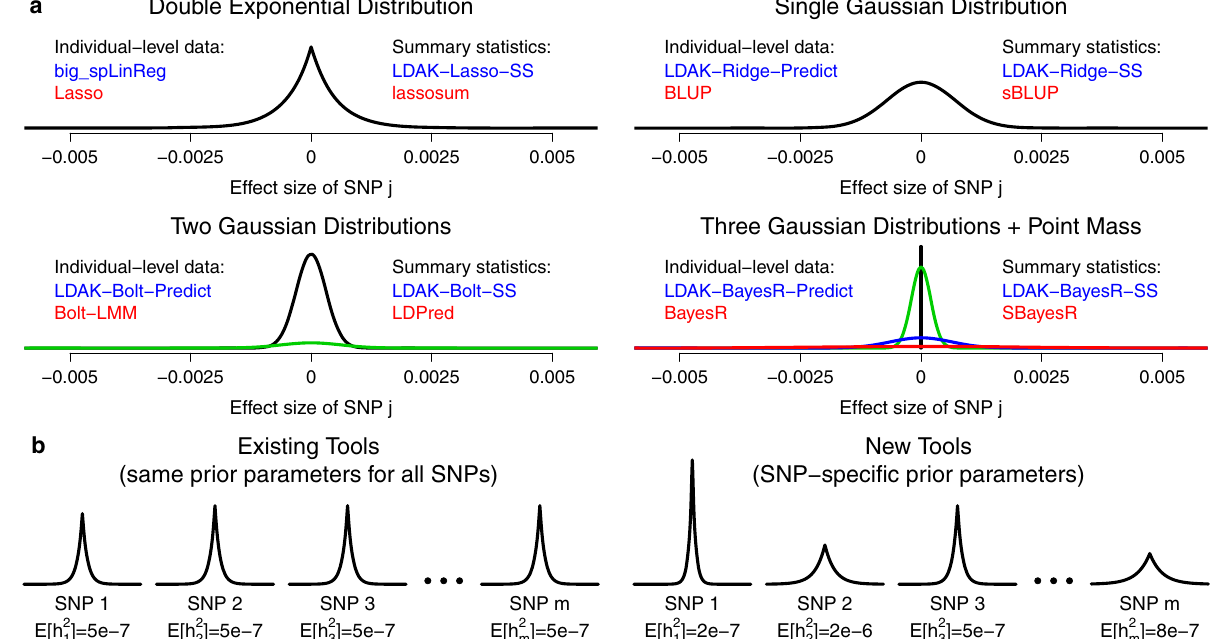
Fig. 1 Prior distributions for SNP effect sizes. a We divide prediction tools based on the form of the prior distribution they assign to SNP effect sizes, and whether they use individual-level data or summary statistics. For each of our eight new tools (names in blue), there is an existing tool that uses the same prior distribution form (names in red). b Having selected the form of the effect size prior distribution, most existing prediction tools use the same parameters for each SNP. Our new tools, by contrast, use SNP-speci fi c prior distribution parameters. To illustrate this difference, we consider lasso-based prediction tools that assign a double exponential prior distribution to standardized SNP effect sizes. While existing tools might, for example, set the variance of the prior distribution to 5e − 7 (so that E[ h 2 j ] = 5e − 7 for all SNPs), our new tools instead let the variance vary across the genome (allowing E[ h 2 j ] to be set according to the chosen heritability